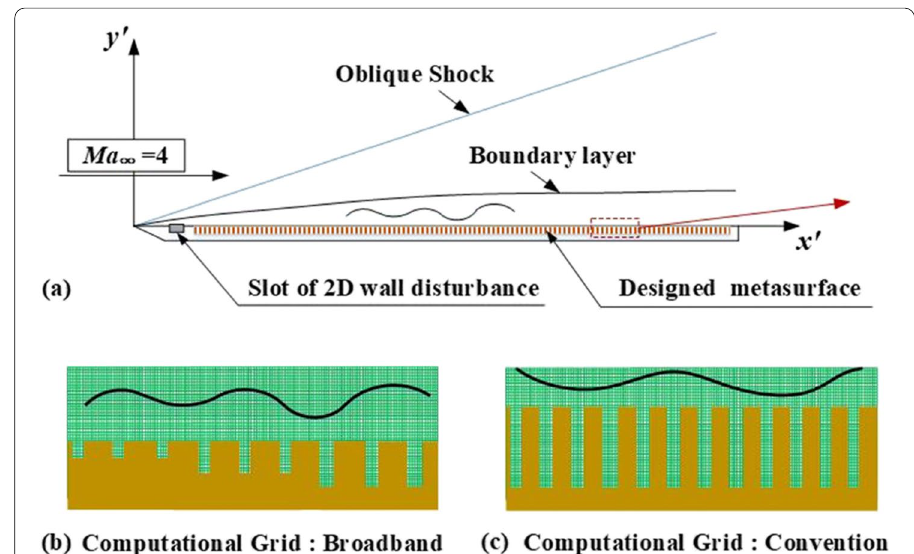
Fig. 2 Schematic drawing of the problem formulation: ( a ) high-speed boundary-layer flow, ( b ) computational grids among the cavities of broadband design, ( c ) computational grids among the cavities of convention